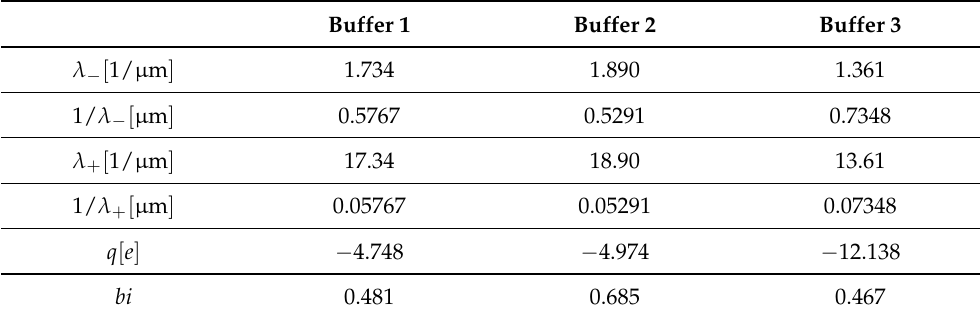
Table 7. Optimal parameters obtained with an accuracy of four digits of precision.